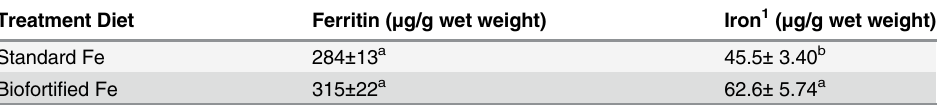
Table 3. Ferritin protein and Fe concentration in the